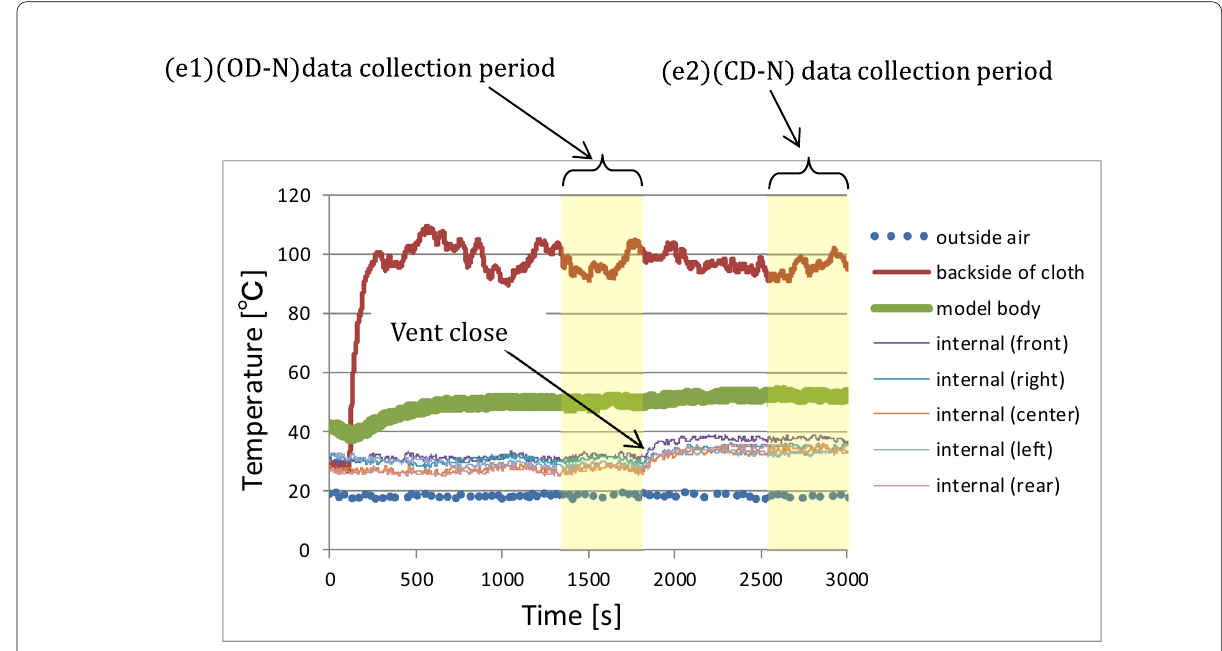
Fig. 11 Temperature measurement results by thermocouples. (e1) (OD-N), (e2) (CD-N)